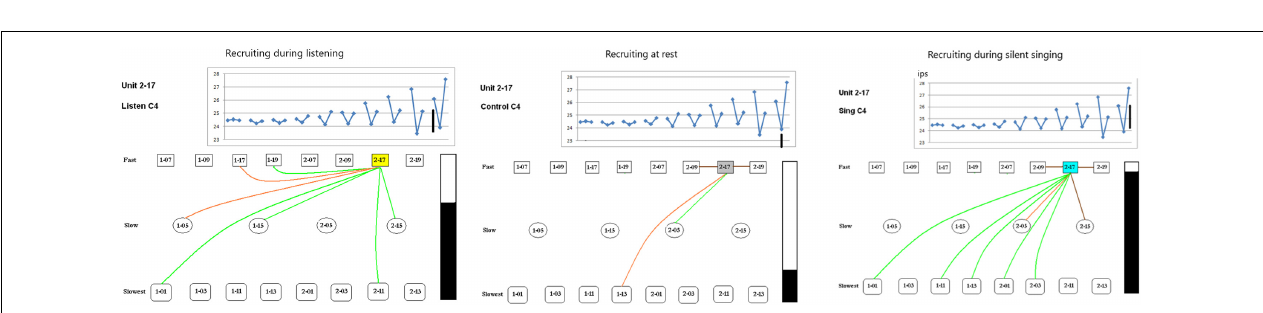
FIGURE 8 | Recruiting of SUs during listening, rest, and silent singing is illustrated as connections between the index SU (#2-17) and fast, slow, or slowest firing units. Green lines indicate increase above baseline firing, brown and red illustrate inhibition of firing to different degrees of inhibition. Tone is C4 (262 Hz). The black bar illustrates the total firing (arbitrary numbers) and is used for comparison between the different tasks. A power point slide in Supplementary Material illustrates trials 4–10.